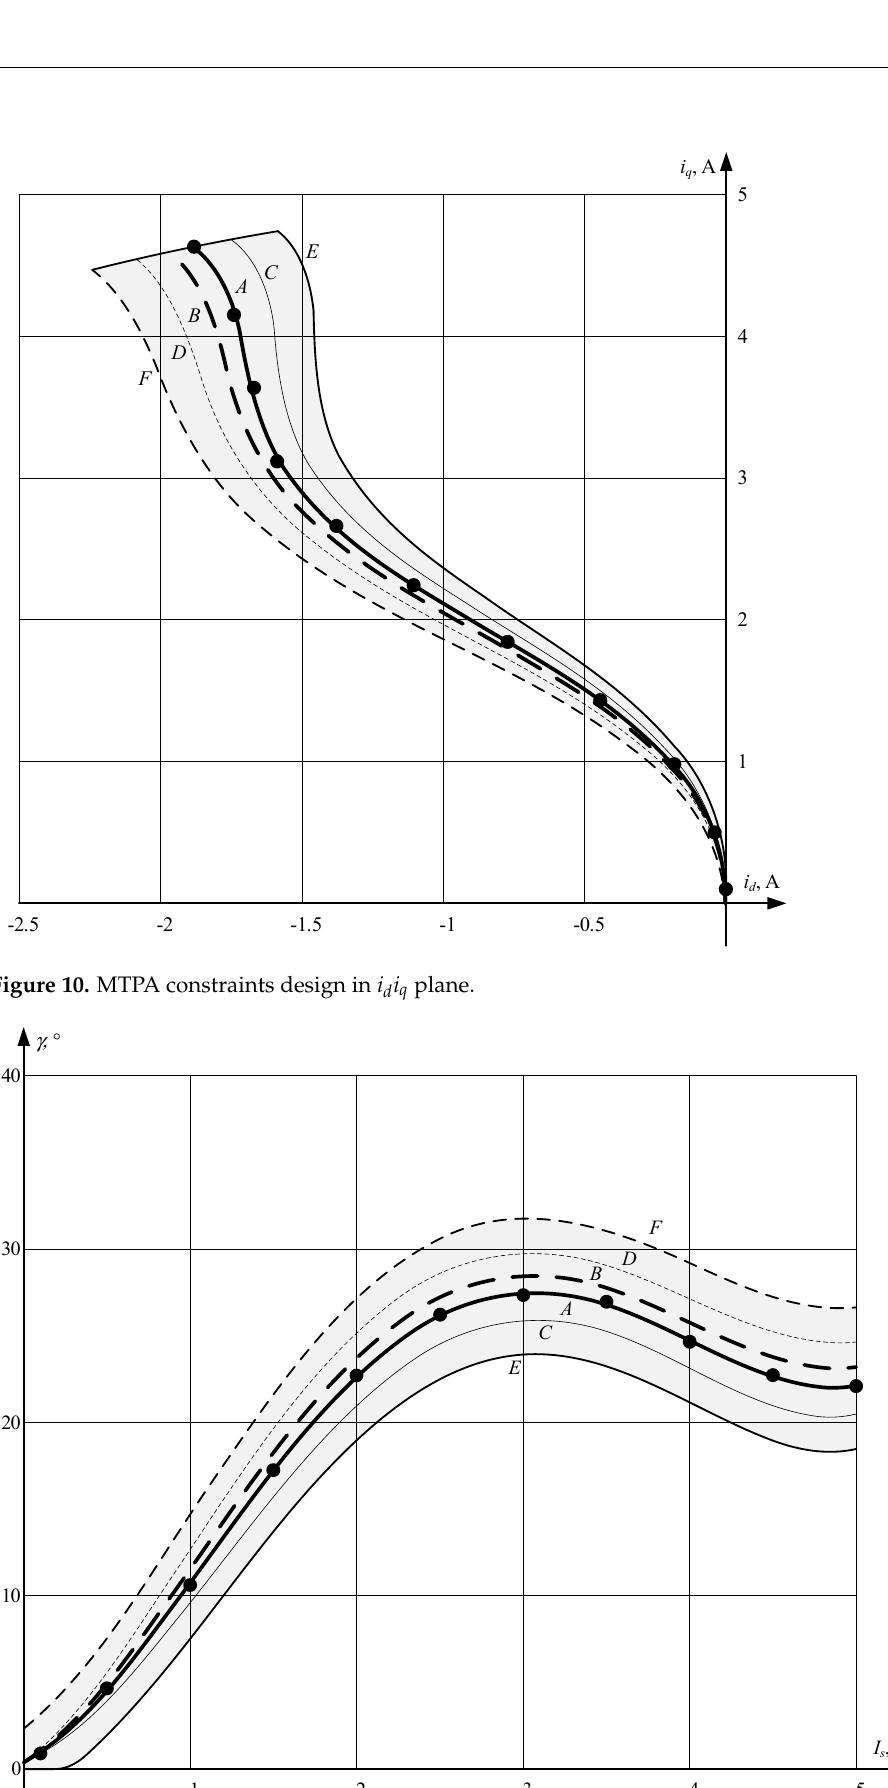
Figure 11. MTPA constraints design for MTPA angle γ.